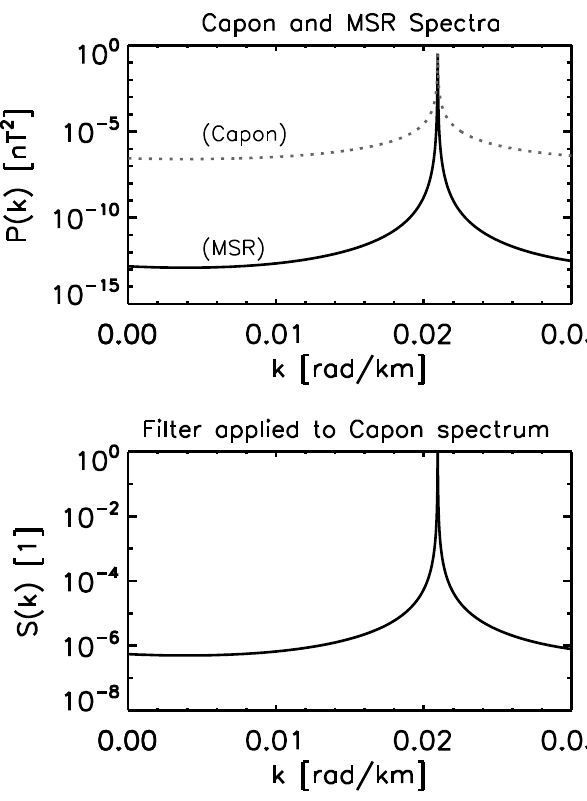
Fig. 2. Top: Capon-spectrum in the wave number domain deter- mined by four-point measurement of synthetic scalar magnetic field data shown in Fig. 1 (dotted curve); the MSR spectrum for the same data set (solid curve). Bottom: Spectrum determined by the normal- ized, extended-MUSIC algorithm for the same data set. The vertical bar represents the confidence